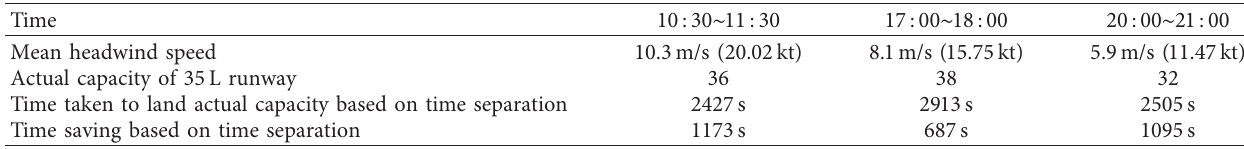
Figure 8: Relationship between headwind speed and time separation, the time separation model can save more time when the wind speed is stronger [34]. Table 15: Theoretical capacity of different periods.